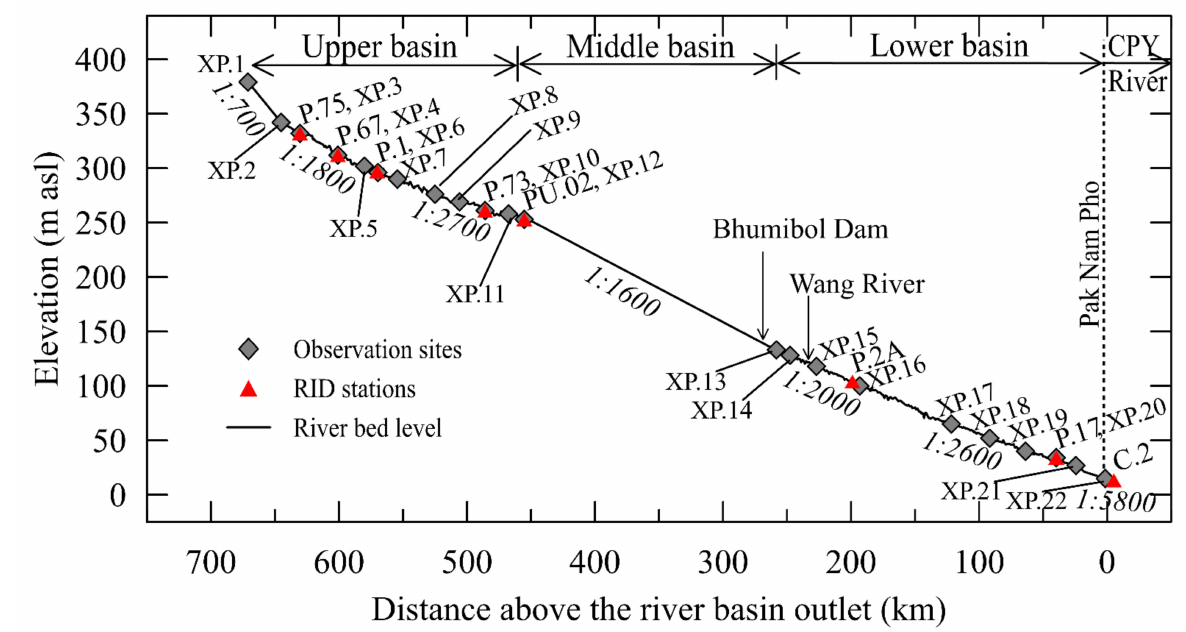
Figure 2. Longitudinal profile of the Ping River showing locations of RID hydrological stations (red triangles) and observation sites (grey diamonds). The zero mark on the x -axis represents the confluence of the Ping and Nan